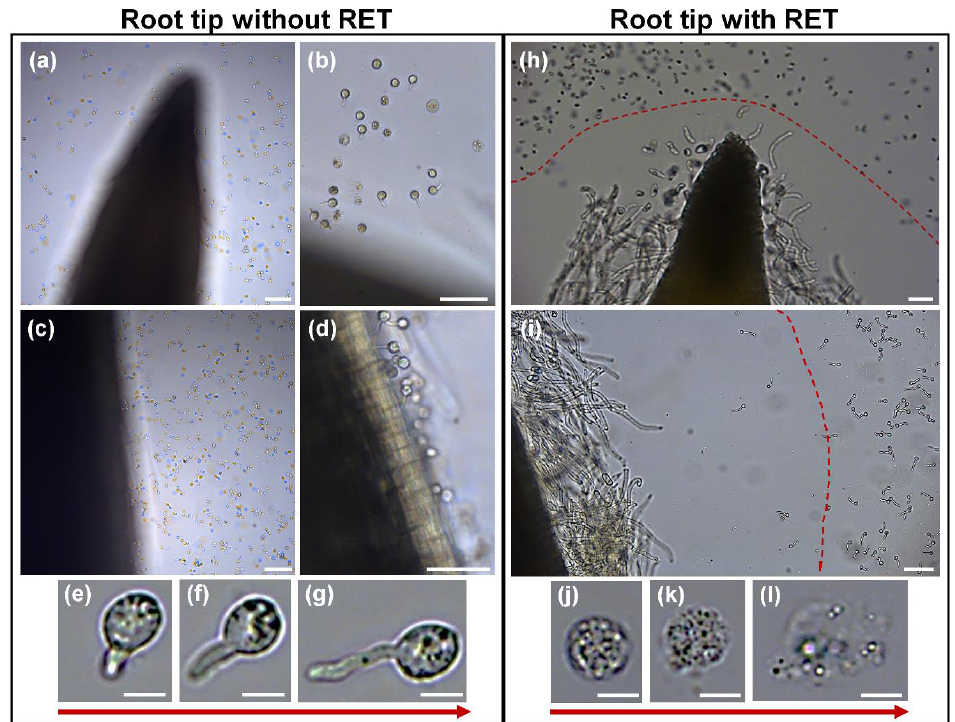
Figure 10. Interaction of root tip with the pathogen Phytophthora parasitica , effect of root extracellular trap (RET). ( a – d ) Root tips devoid of their border cells and mucilage or ( h , i ) intact root tips were inoculated with zoospores and observed after 15–30 min. ( e – g ) RET-less root tip was rapidly colonized by the zoospores that started to germinate after only 15 min. ( h , i ) In contrast, the zoospores did not or very rarely reached intact root tips (even after 30 min of inoculation) and did not colonize them. The vast majority of zoospores could not penetrate the zone of mucilage (red dashed line). ( j – l ) The very few zoospores that reached that zone or those that penetrated the mucilage underwent a very rapid lysis and died 15–30 min after inoculation. Scale bars: ( a , c ) 100 µm; ( b , d , h , i ) 50 µm; and ( e – g , j – l ) 10 µm.